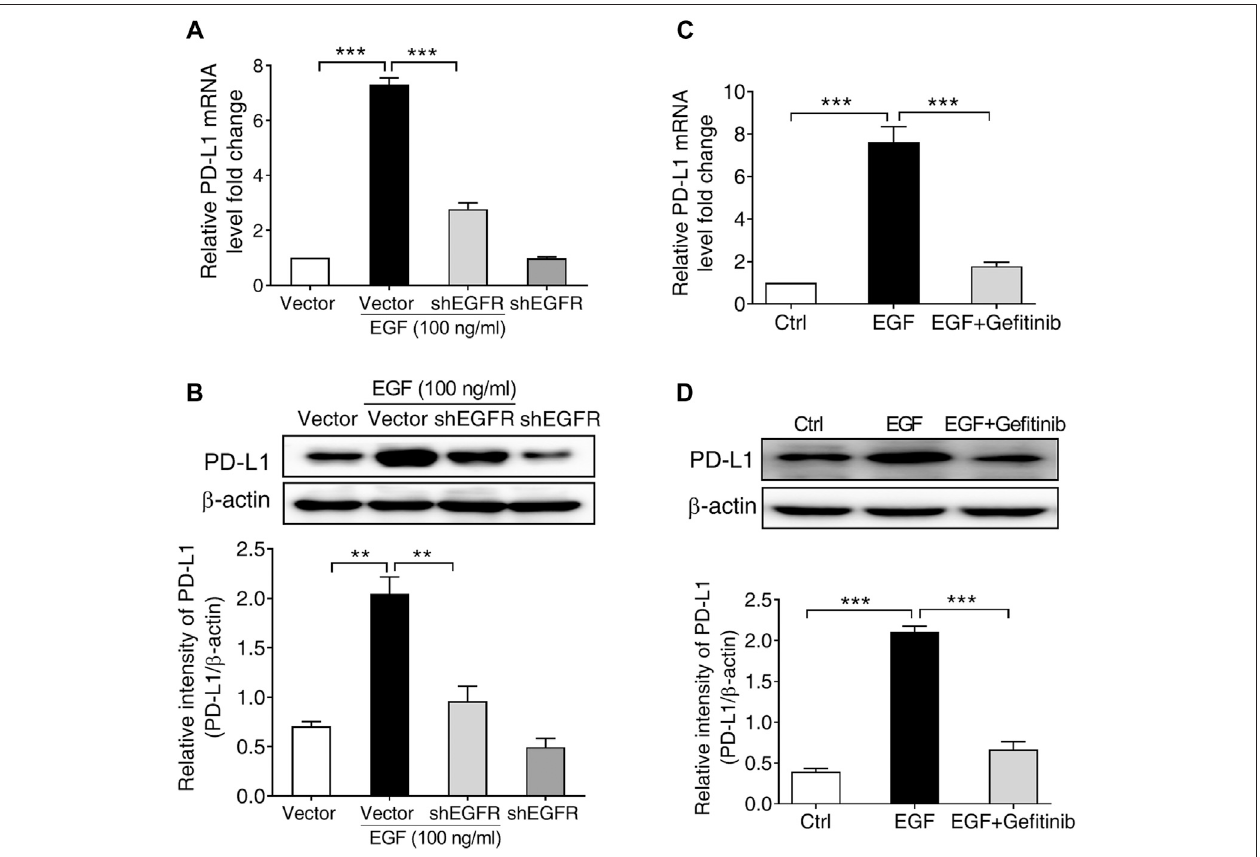
FIGURE 2 | EGFR activation is required for PD-L1 expression in SNU-368 cells. (A,B) Knockdown of EGFR with speci fi c shRNA reversed EGF-induced PD-L1 mRNA (A) andprotein (B) expressionsinSNU-368cells.At24 hpost-transfection,thecellswereincubatedinthepresenceorabsenceof100 ng/mlEGFfor12 h.** p < 0.01, *** p < 0.001, one-way ANOVA, n (cid:1) 4 independent experiments per group. (C,D) EGF-induced upregulation of PD-L1 mRNA (C) and protein (D) was blocked by ge fi tinib. *** p < 0.001, one-way ANOVA, n (cid:1) 5 independent experiments per group.